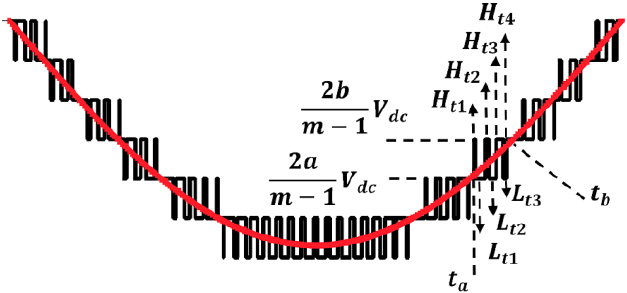
Figure 9. Pulse train of a voltage step in the inverter output voltage waveform.